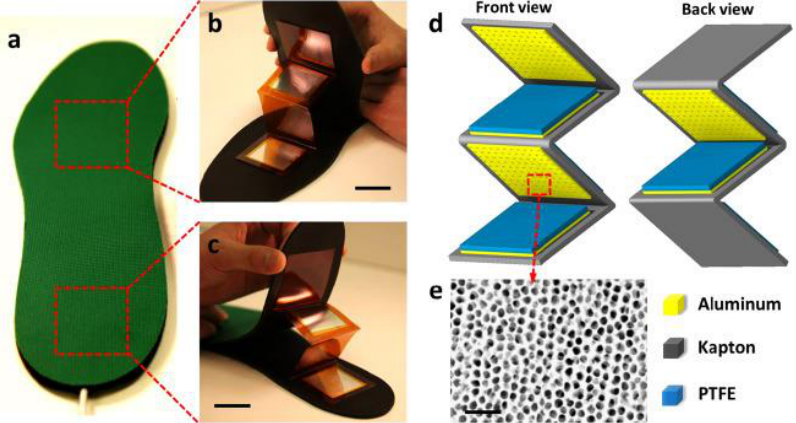
Figure 9. Structural design of an energy-generating shoe insert based on flexible TENGs. ( a ) Photo of an energy-generating shoe insert. ( b ) Photograph of the internal structure of the insert. The scale bar is 2 cm. ( c ) Photograph of the internal structure of the insert. ( d ) Structure of multilayered elastic TENG. The zig-zag structure of the substrate accommodates three layers in one TENG. ( e ) SEM image of nanopores formed on the surface of aluminum foils. The scale bar is 200 nm ([57] license number 5443011421697). Comparison of triboelectric harvesters are presented in Table 6. Table 6. Comparison triboelectric harvesters.